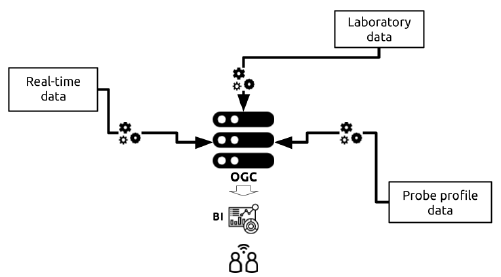
Figure 2. Graphical representation of main data sources available for Lake Lugano.